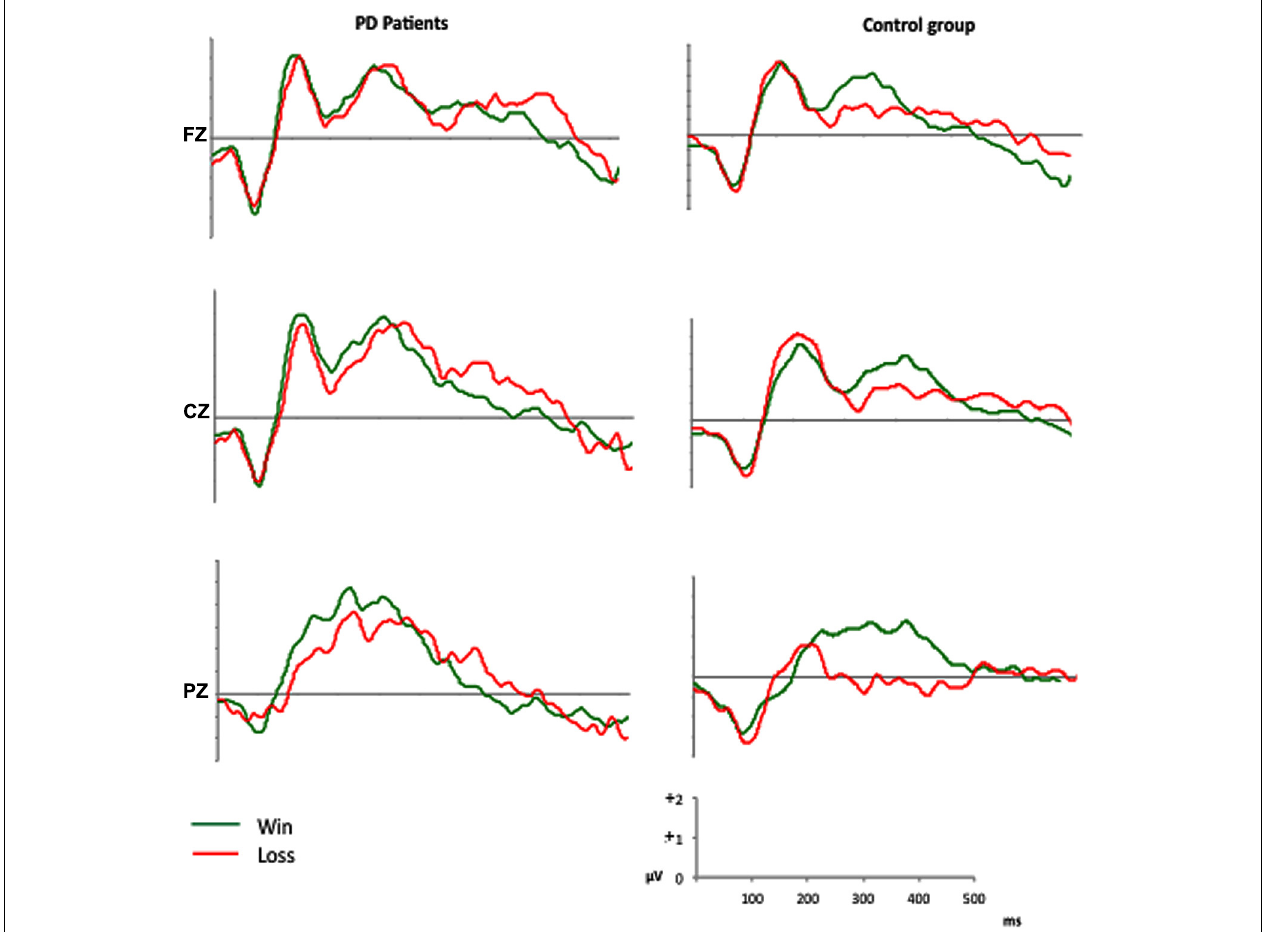
FIGURE 2 | Grand average ERPs in the anterior (Fz), central (Cz), and parietal (Pz)